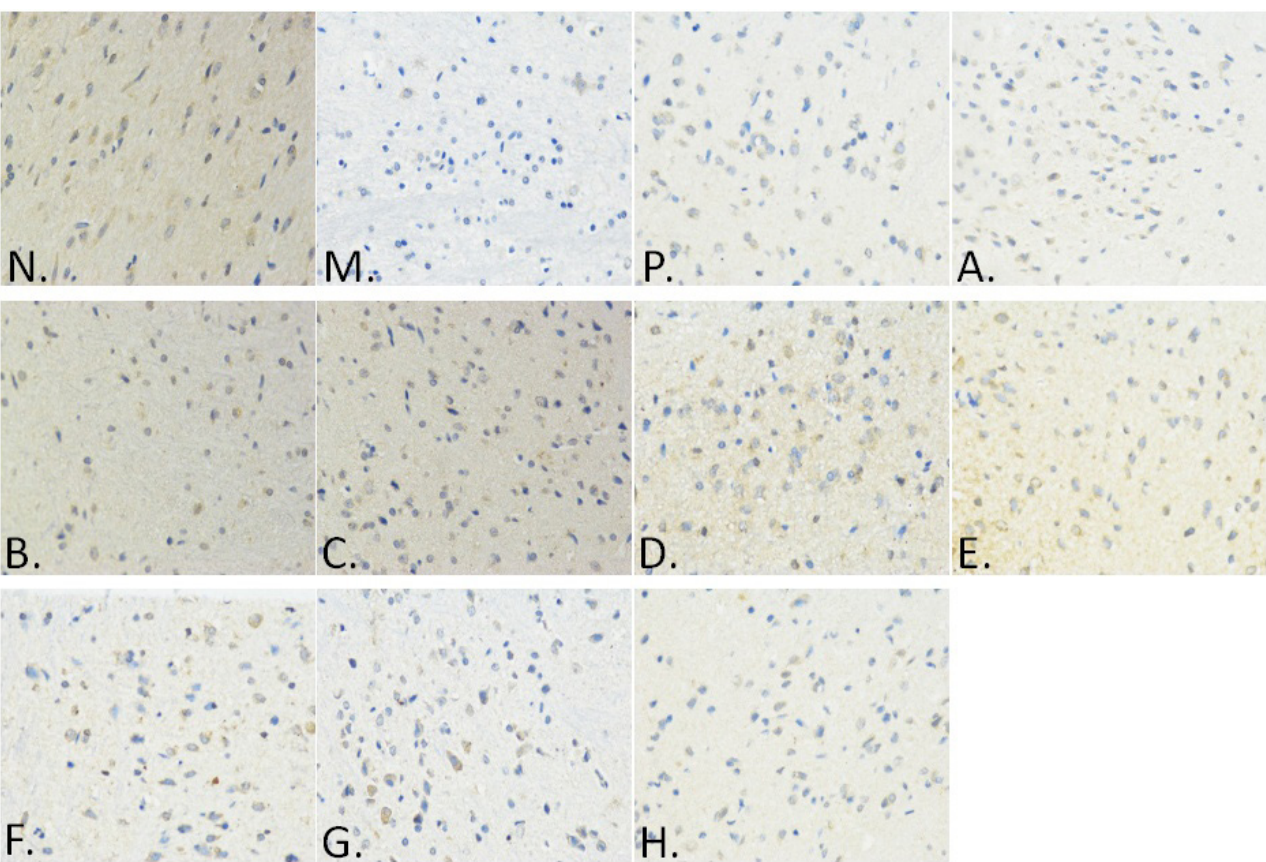
FIGURE 9 – Dopamine D2 receptor expression in the hypothalamus was observed by microscope (original magnification, 400×). The positive reaction of dopamine D2 receptor in the hypothalamus was brown in cytoplasm, and the darker the color was, the greater its positive expression was (N) normal controls; (M) model group; (P) bromocriptine group; (A) 0.25 cm bud of malt group; (B) 0.50 cm bud of malt group; (C) 0.75 cm bud of malt group; (D) 1.00 cm bud of malt group; (E) 1.25 cm bud of malt group; (F) 1.50 cm bud of malt group; (G) 1.75 cm bud of malt group; (H) 2.00 cm bud of malt